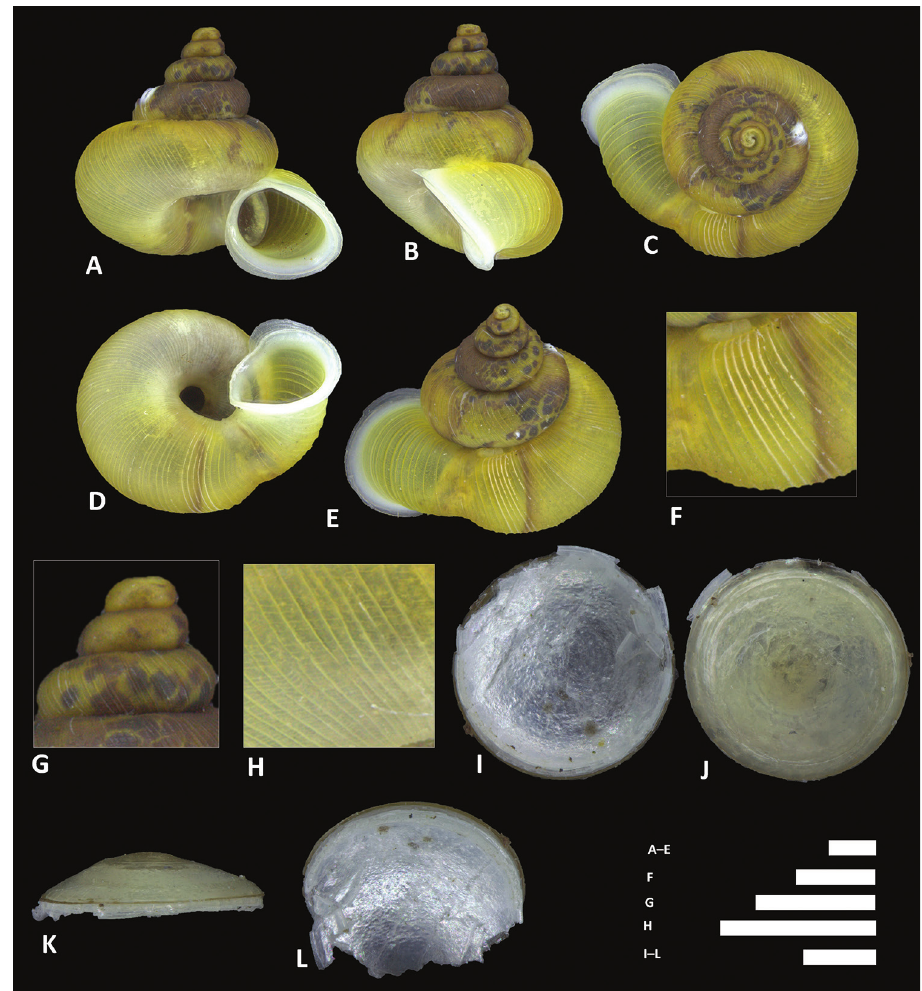
Figure 27. Alycaeus selangoriensis sp. n. A–E Shell of holotype, BOR/MOL 12988 F–H Close up of shell of holotype, BOR/MOL 12988 I–L Operculum of paratype, BOR/MOL 6808. Scale